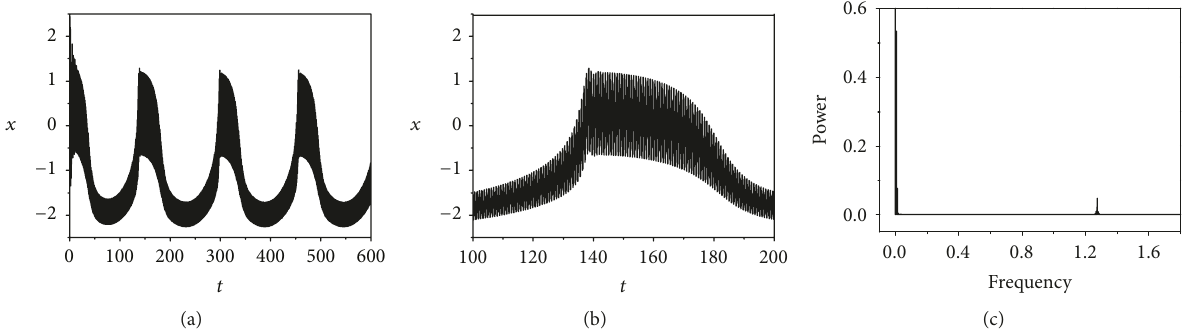
Figure 9: Sampled time series of membrane potential and power spectrum of electrical activity.